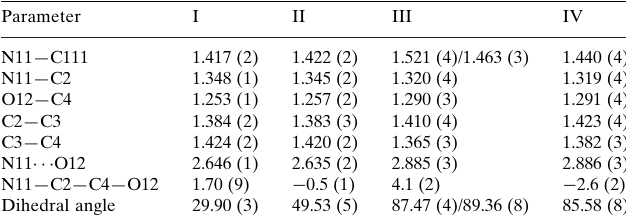
Comparative geometric parameters (A˚ , (cid:2) ) for free and coordinated N , O - bidendate ( N , O -bid) compounds.